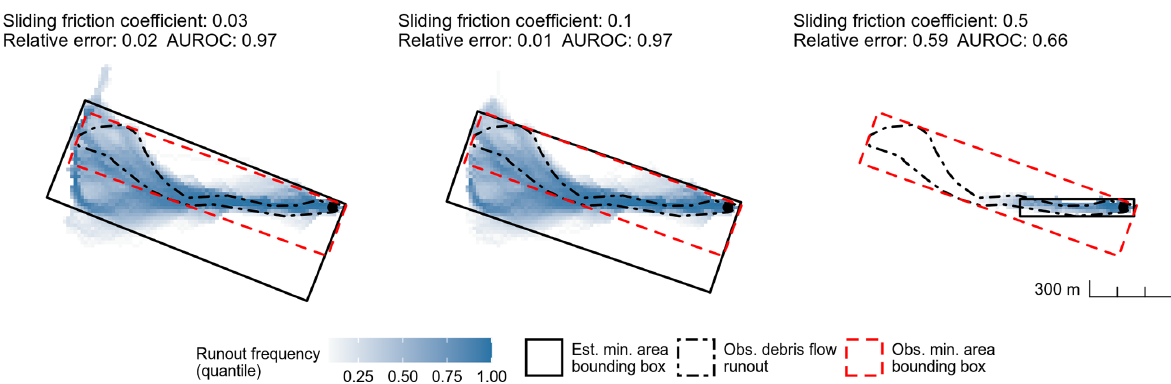
Figure 2. Illustration of runout-distance optimization of the sliding friction coefficient µ using a minimum-area bounding box as a measure of travel distance – M/D fixed at 40m.